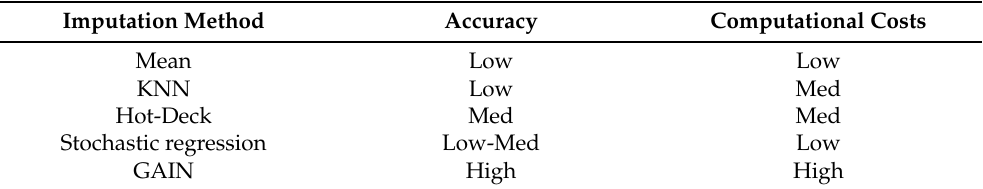
Table 1. Overview of the advantages and disadvantages of some existing strategies for missing data